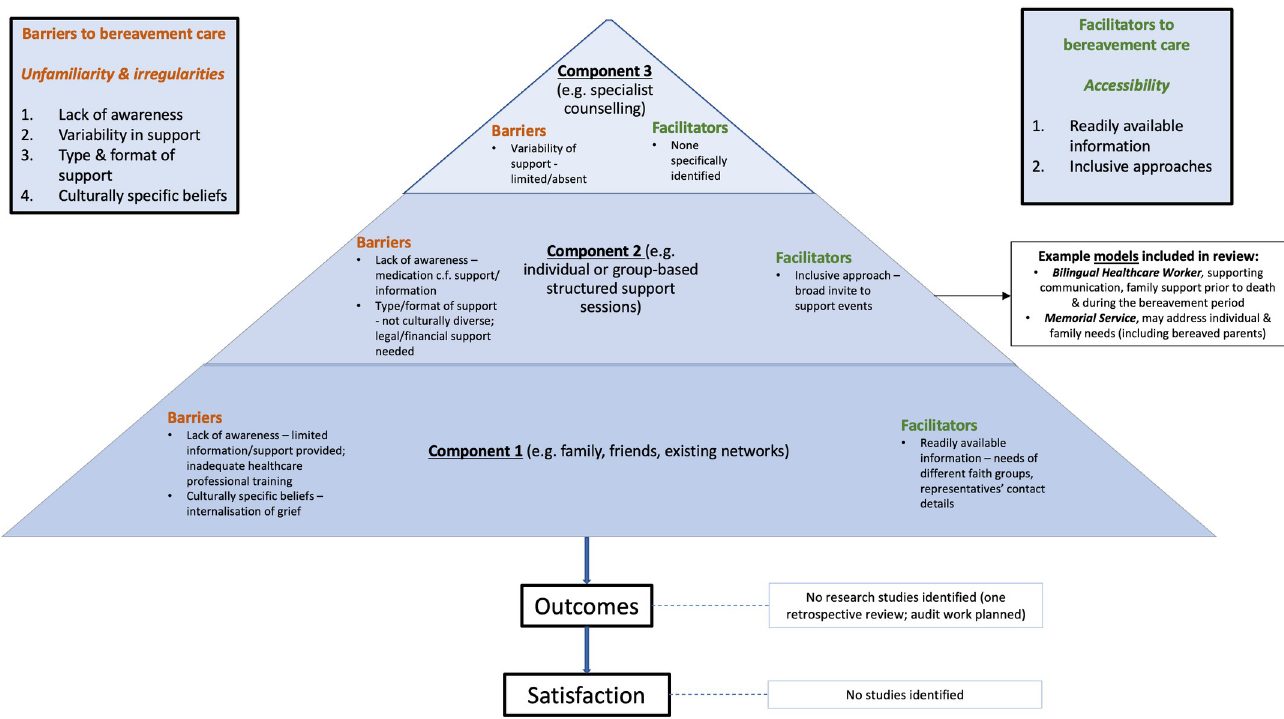
Fig 2. A preliminary conceptual map of existing facilitators, barriers, outcomes and satisfaction relating to bereavement care for ethnic minority groups based on findings from included studies.